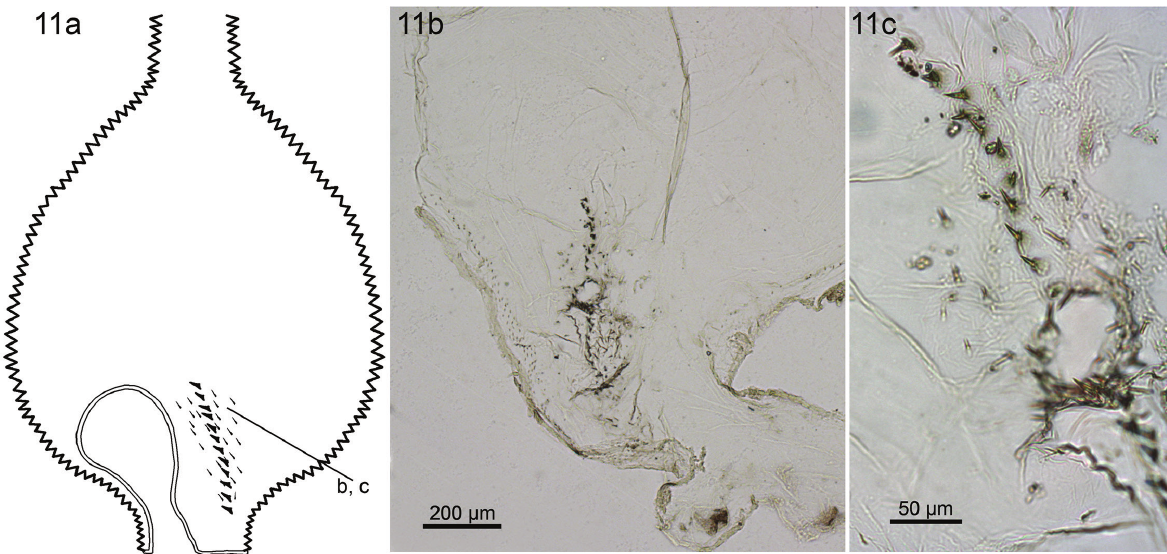
Figure 11. Ibitermes curupira . (a) Schematic drawing of P1 showing arrangement of spines. (b, c) Photomicrographs: (b) General view of longitudinal row of stout spines, with some robust spines nearby (middle of P1 wall slightly damaged); (c) Detail of stout spines.